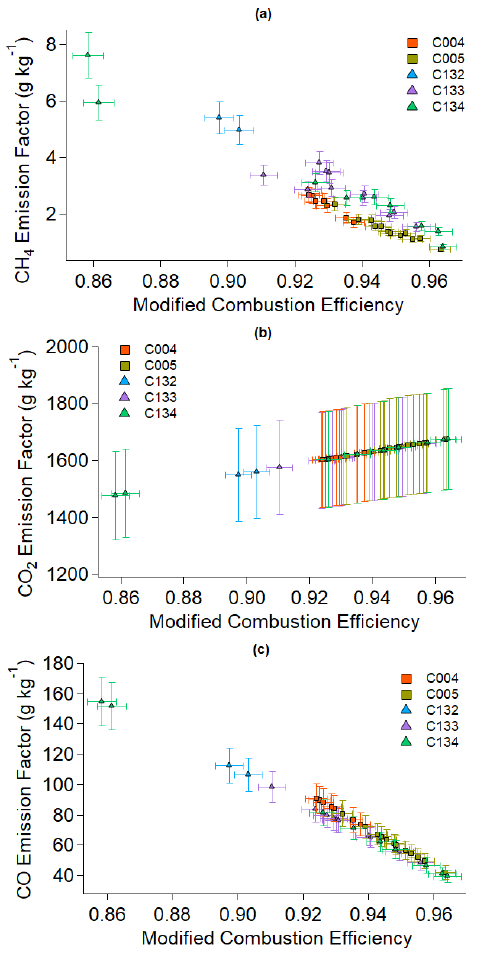
Figure 7. (a) Methane, (b) CO 2 , and (c) CO EF vs. modified com- bustion efficiency for all biomass burning plumes sampled over all flights (squares are MOYA-I and triangles are MOYA-II). Points are coloured by flight number.